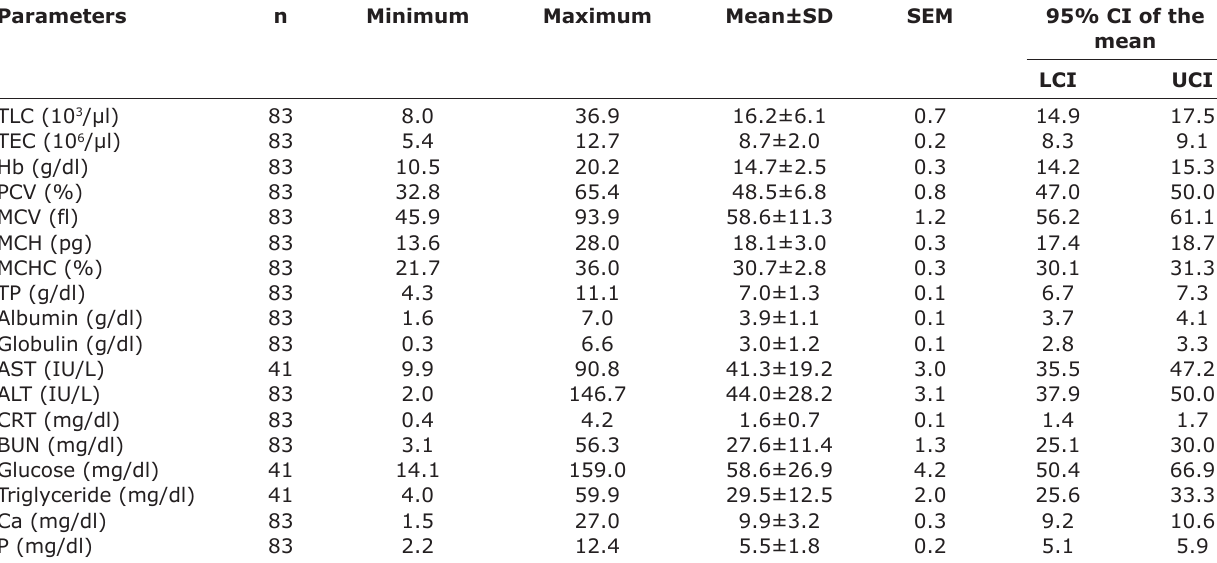
Table-1: Overall hematology and serum biochemistry results for Indian leopards ( Panthera pardus fusca ) from BBP and MLRC. Parameters n